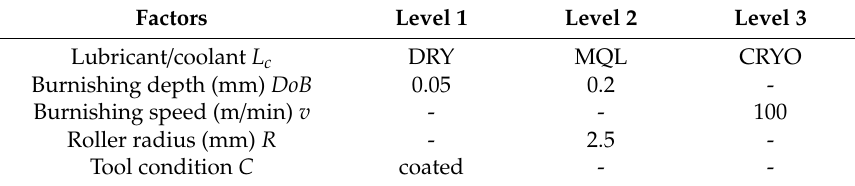
Table 7. Design of experiments for results validation in burnishing Ti-6Al-4V alloy.